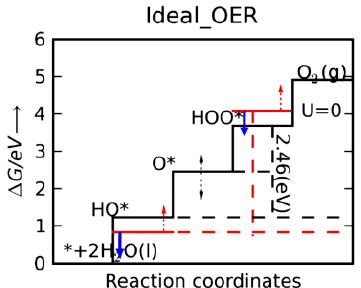
Figure 21. The free energy diagram for the OER ideal catalyst. The black continuous line is the OER ideal catalyst, where the over-potential is 0 eV because all free energies of the intermediate steps equal to 1.23 V. Red lines show the actual HOO* and HO* levels for the catalysts, which have to be moved down and up, respectively, in order to reduce the over-potential. Unfortunately, a metal oxide catalyst usually changes these two levels in the same direction, as indicated by the red (move up) and blue arrows (move down). O* level is positioned between the HOO* and HO* level. Reprinted with permission from ref. [81]. Copyright 2012. The Royal Society of Chemistry.